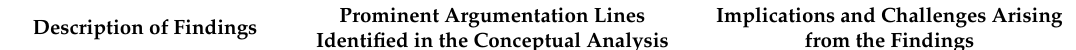
Table 4. Summary of conceptual reflections regarding health literacy antecedents and their contextual